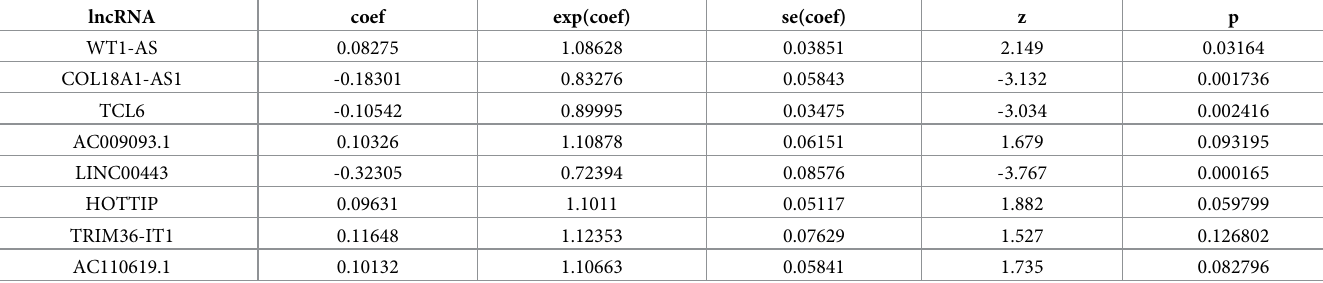
Table 9. Multivariate cox regression analysis was performed on eight prognostic lncRNAs of patients with KIRC.